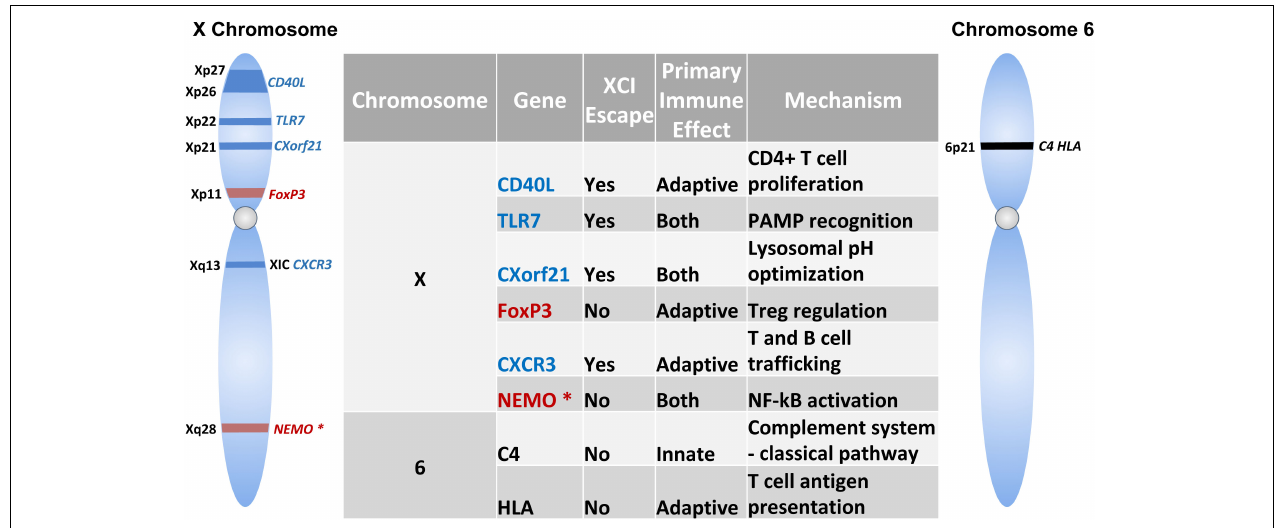
FIGURE 3 | Immune-related Genes implicated in the sex-based differences in the immune response. Schematic shows genes encoded on the X-chromosome and chromosome 6. Table lists the role of these genes in innate and/or adaptive immunity and mechanism of action. Genes indicated in blue text escape X chromosome inactivation, while those that do not undergo escape are indicated in red. NEMO is marked with an asterisk (*) to specify skewed X chromosome